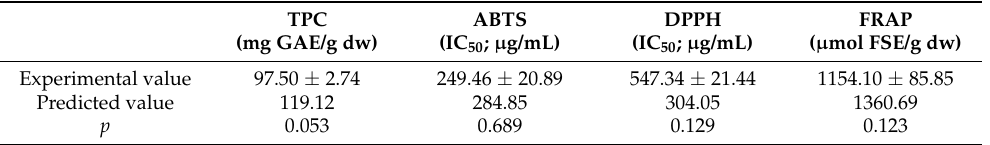
Table 3. TPC and antioxidant/antiradical activity evaluated by ABTS, DPPH and FRAP assays of the optimal extract of kiwiberry leaves (10% w / v ; 31.11 min; 30 W/m 2